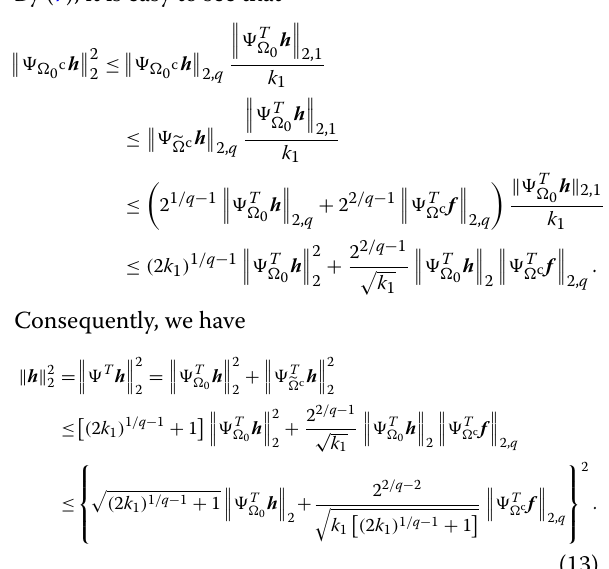
By (7), it is easy to see